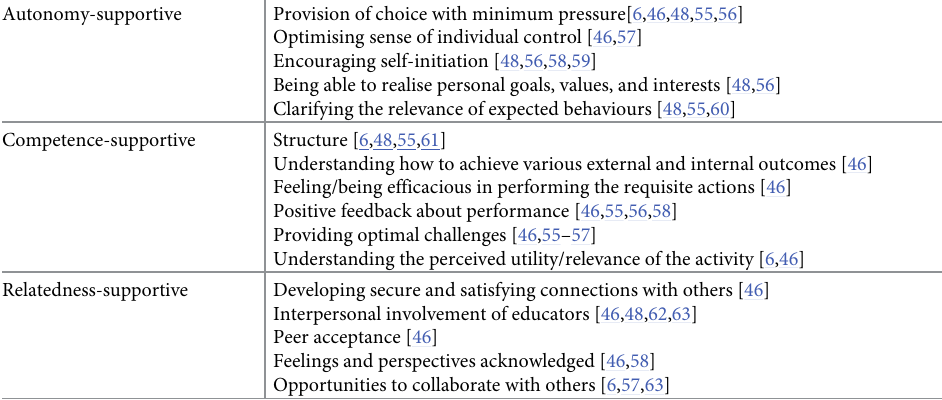
Table 1. Contextual factors that are supportive of autonomy, competence and relatedness needs.